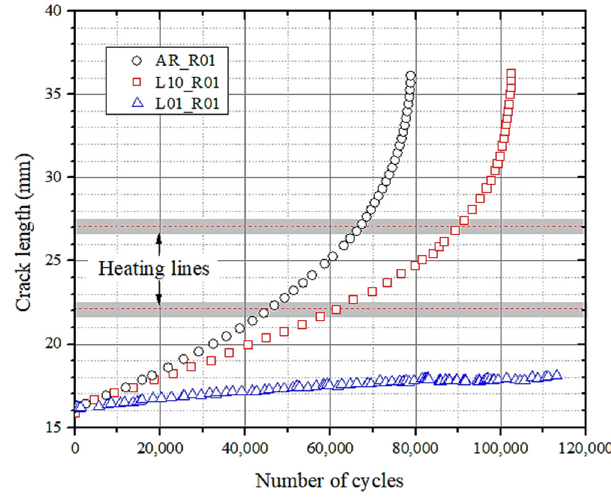
Figure 4. FCG test results: crack length vs. number of cycles for R = 0.1.